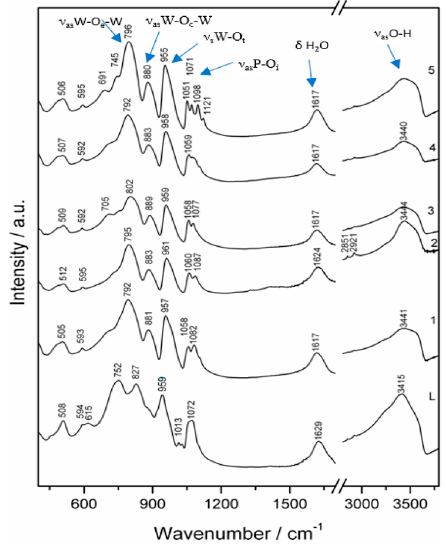
Figure 6. FT-IR spectra of ligand L and complexes 1–5. The more intensive vibration band from 3415 cm − 1 in the spectrum of L has shifted to higher energies between 3440 and 3444 cm − 1 in the spectra of 1–5 and is attributed to the stretching vibration of coordination water involved in hydrogen bonds, the ν as (OH) vibration. The medium vibration band from 1629 cm − 1 in L was assigned to δ (OH) in- plane vibration of water molecules involved in hydrogen bonds and shifted between 1617 and 1624 cm − 1 for complexes 1–5 [15,20–22]. The vibration bands between 1000 and 1100 cm − 1 were assigned to an asymmetrical stretch band ( ν as (P-O i )), where O i is the internal oxygen bond between phosphorus and addenda atoms (tungsten or vanadium) in L, coordinated at transition metal cation in complexes 1–5 , respectively. Monolacunary polyoxometalate L has shown an intense band at 1072 cm − 1 , a weak shoulder around 1100 cm − 1 and a very weak split band between 1013 and 1040 cm − 1 . In complexes 1–5 vibration bands of P-O i bonds have shifted to higher energies, indicating that the free position of monolacunary structure L was occupied by the transitional metal cation M and intensity bands corresponding to ν as (P-O i ), were recorded between 1051 and 1060 cm −